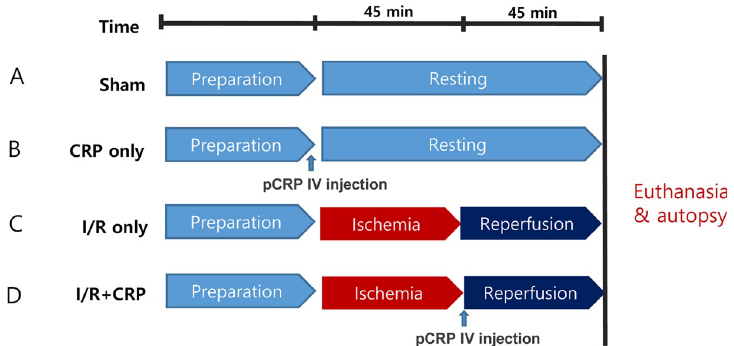
Fig 2. Schematic illustration of experimental protocols. (A) Sham group. (B) CRP-only group. (C) I/R-only group. D, I/R+CRP group.